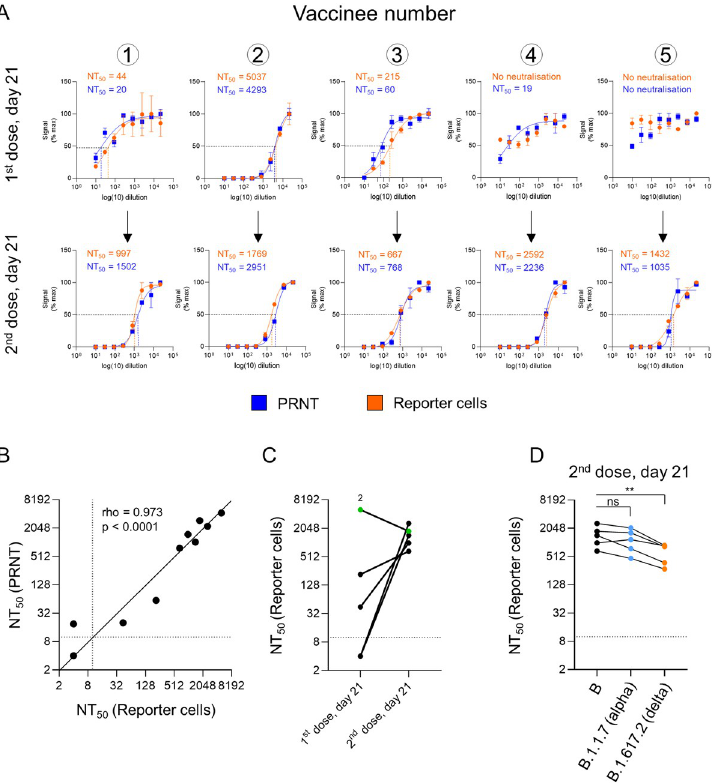
Fig 5. Quantitation of neutralising activity in human serum samples. ( A-D ) Measurement of neutralising antibody titres after inoculation with Pfizer-BioNTech BNT162b2 mRNA vaccine. ( A ) Neutralisation curves and NT50s for serum samples from 5 healthy control donors 21 days after their 1 st (upper panels) or 2 nd (lower panels) doses of BNT162b2 vaccine measured using either a Plaque Reduction Neutralization Test (PRNT, blue) or clone B7 reporter cells (orange). For PRNTs, SARS-CoV-2-ZsGreen viral stock (MOI = 0.001) was pre-incubated with a 3-fold dilution series of heat-inactivated serum before addition to VeroE6 cells. A semi-solid overlay was added after 2 h, and plaques enumerated by automated microscopy (Cellomics) 48 h post-infection. For the reporter cells, SARS-CoV-2 viral stock (MOI = 0.01) was pre-incubated with a 3-fold dilution series of heat-inactivated serum before addition to cells. Firefly and Renilla luciferase activities were measured by luminometry 24 h post-infection. Plaque number and Firefly/Renilla luminescence are shown as % maximum. Mean values ± SEM are shown for experiments performed in duplicate (PRNT) or triplicate (reporter cells), representative of 2 independent experiments. Illustrative data from PRNTs are included in S6 Fig . ( B ) Correlation between NT50s obtained for each sample ( A ) using either PRNTs (y-axis) or reporter cells (x-axis), with a solid black identity line (line of equality). Dotted lines indicate the limit of detection (lowest dilution) for each assay. rho, Spearman’s rank correlation coefficient. ( C ) Comparison between NT50s for each donor after 1 st and 2 nd doses of BNT162b2 vaccine obtained using reporter cells ( A ). Samples with no detectable neutralising activity at the lowest dilution (dotted line) are plotted at an arbitrary NT50 of 4. Donor 2 is highlighted in green. ( D ) Measurement of neutralising antibody titres against lineage B.1.1.7 (alpha) and B.1.617.2 (delta) variants of concern. The same serum samples from healthy control donors obtained 21 days after their 2 nd dose of BNT162b vaccine were processed as described in ( A ) but using lineage B.1.1.7 or B.1.617.2 viral stocks (MOI = 0.01). Representative of 2 independent experiments. Data for the lineage B.29 viral stock are as shown in A-C . �� p <